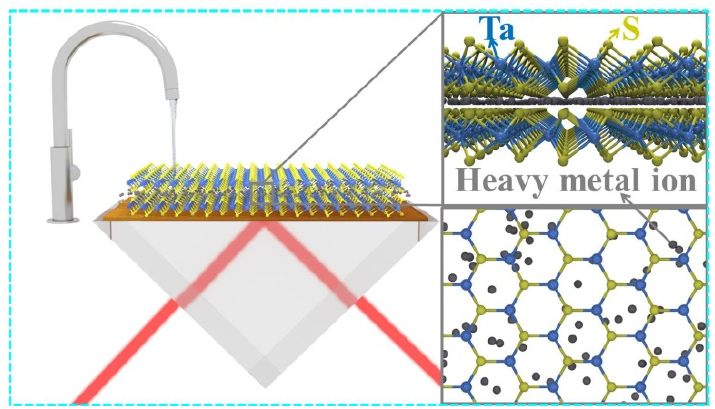
Figure 1. TaS 2 nanoflakes as the sensing layer to detect trace mercury ions in SPR